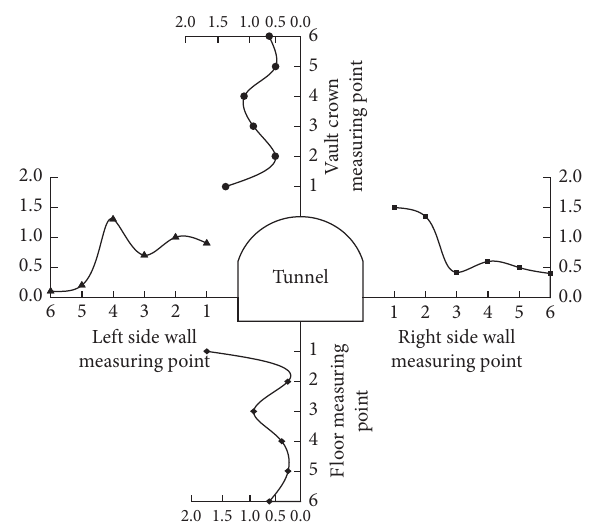
Figure 7: Changing curves of radial displacements for model